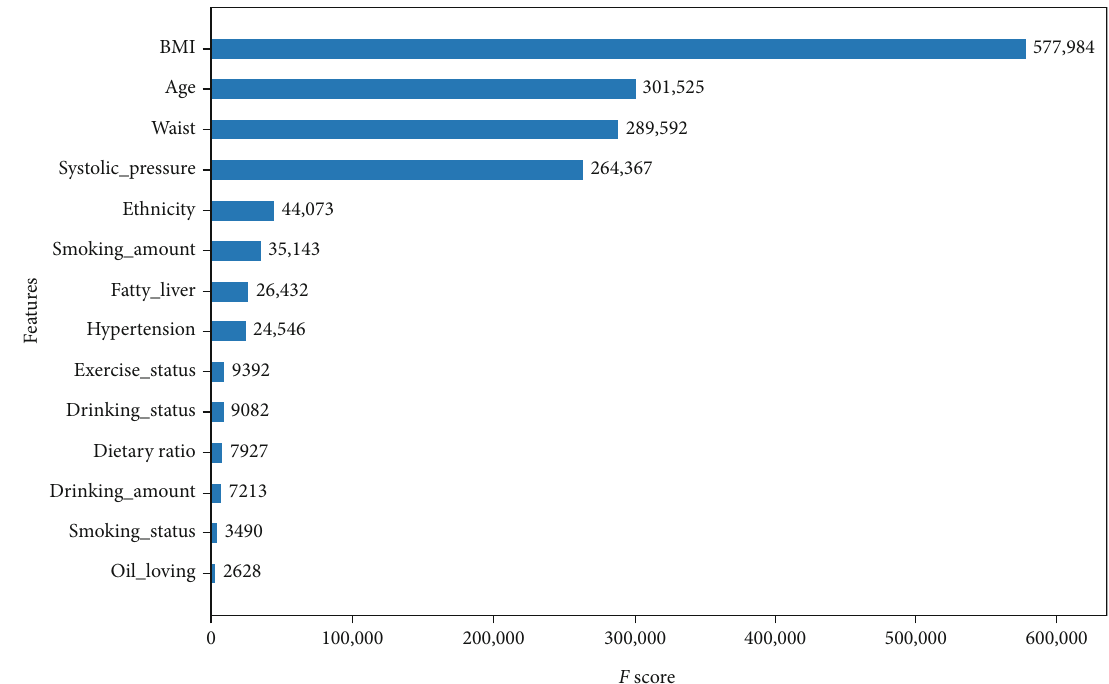
Figure 4: Feature importance contributed to the XGBoost model measured by the F